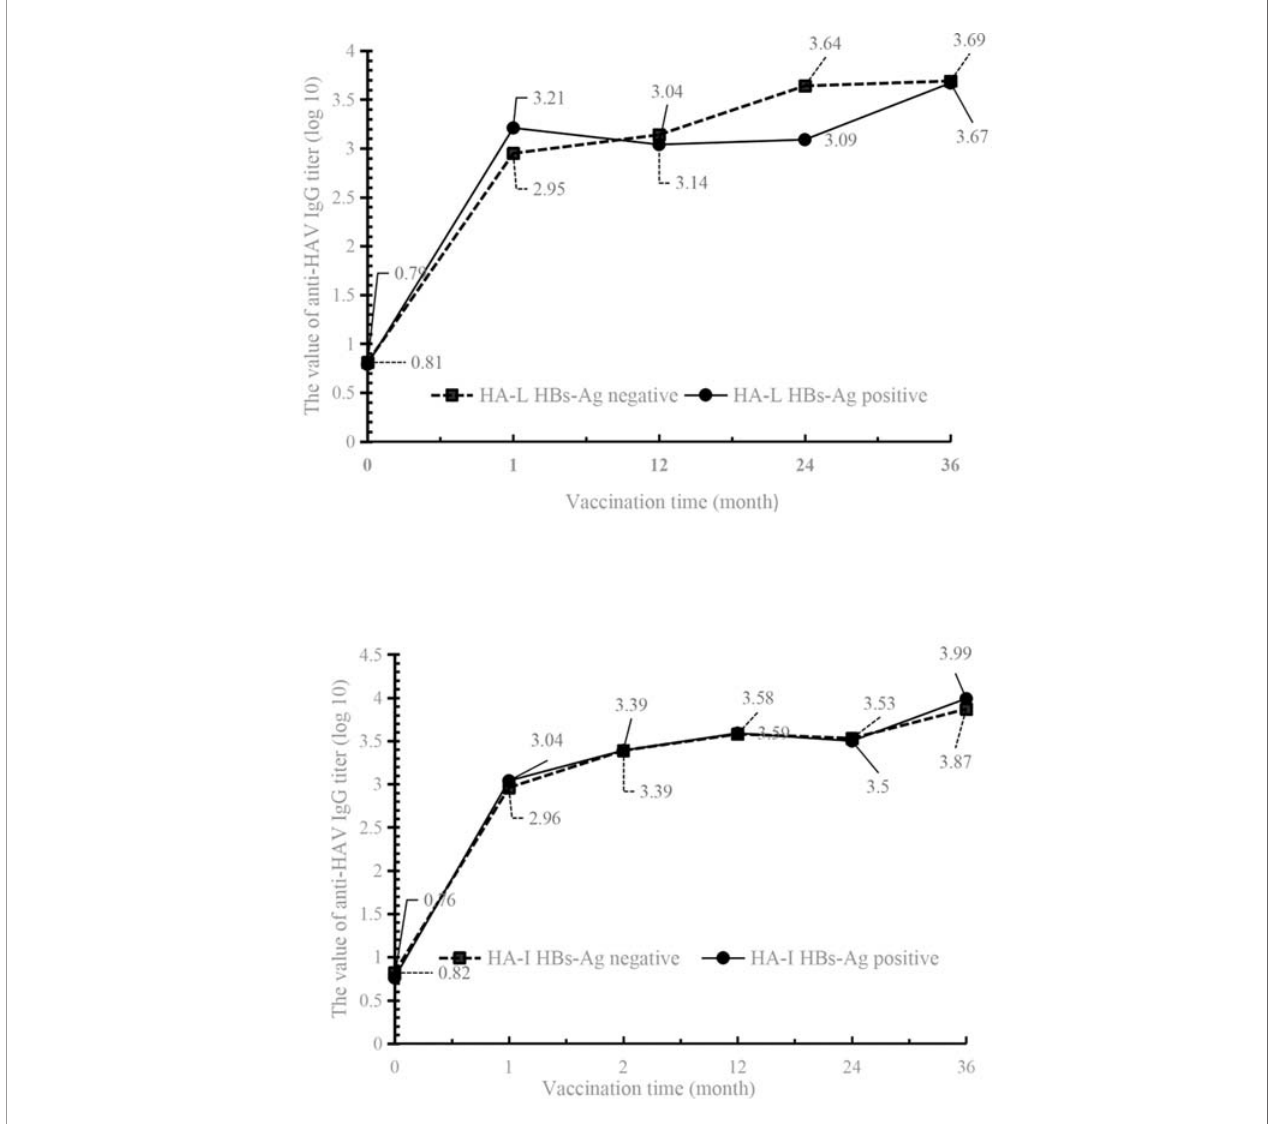
FIGURE 3 | The values of anti-HAV IgG titer in HBs-Ag-positive or -negative participants of HA-L and HA-I